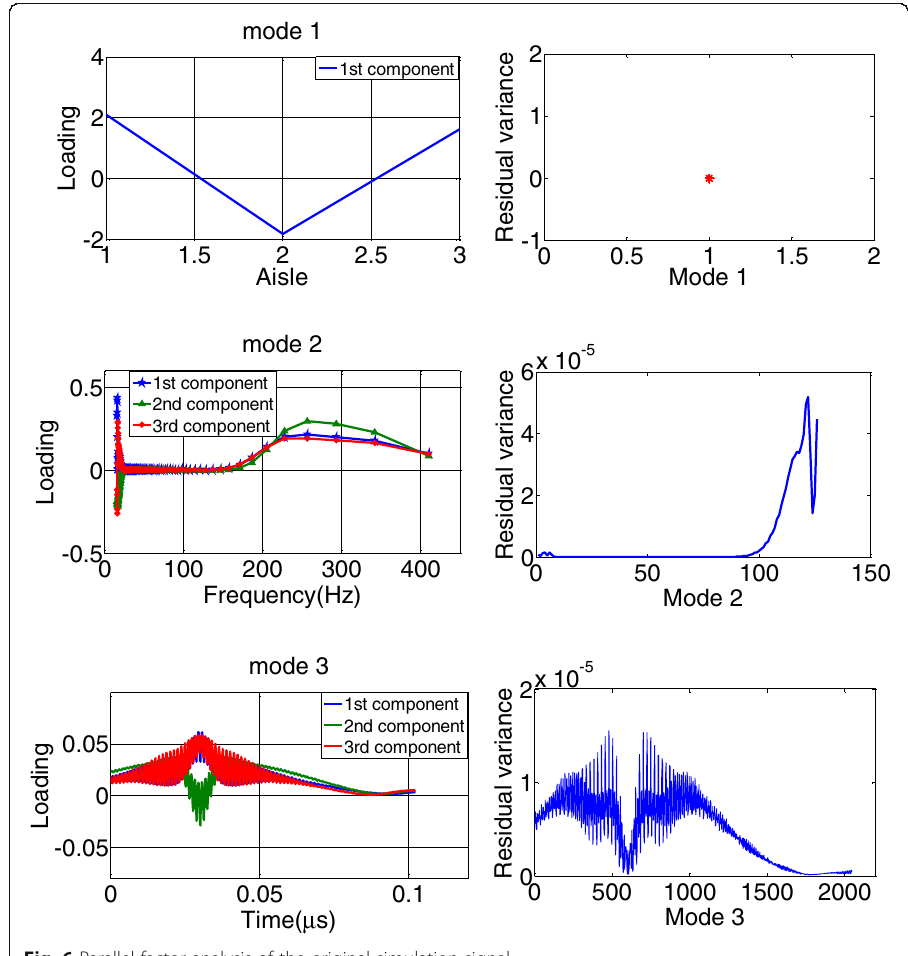
Fig. 6 Parallel factor analysis of the original simulation